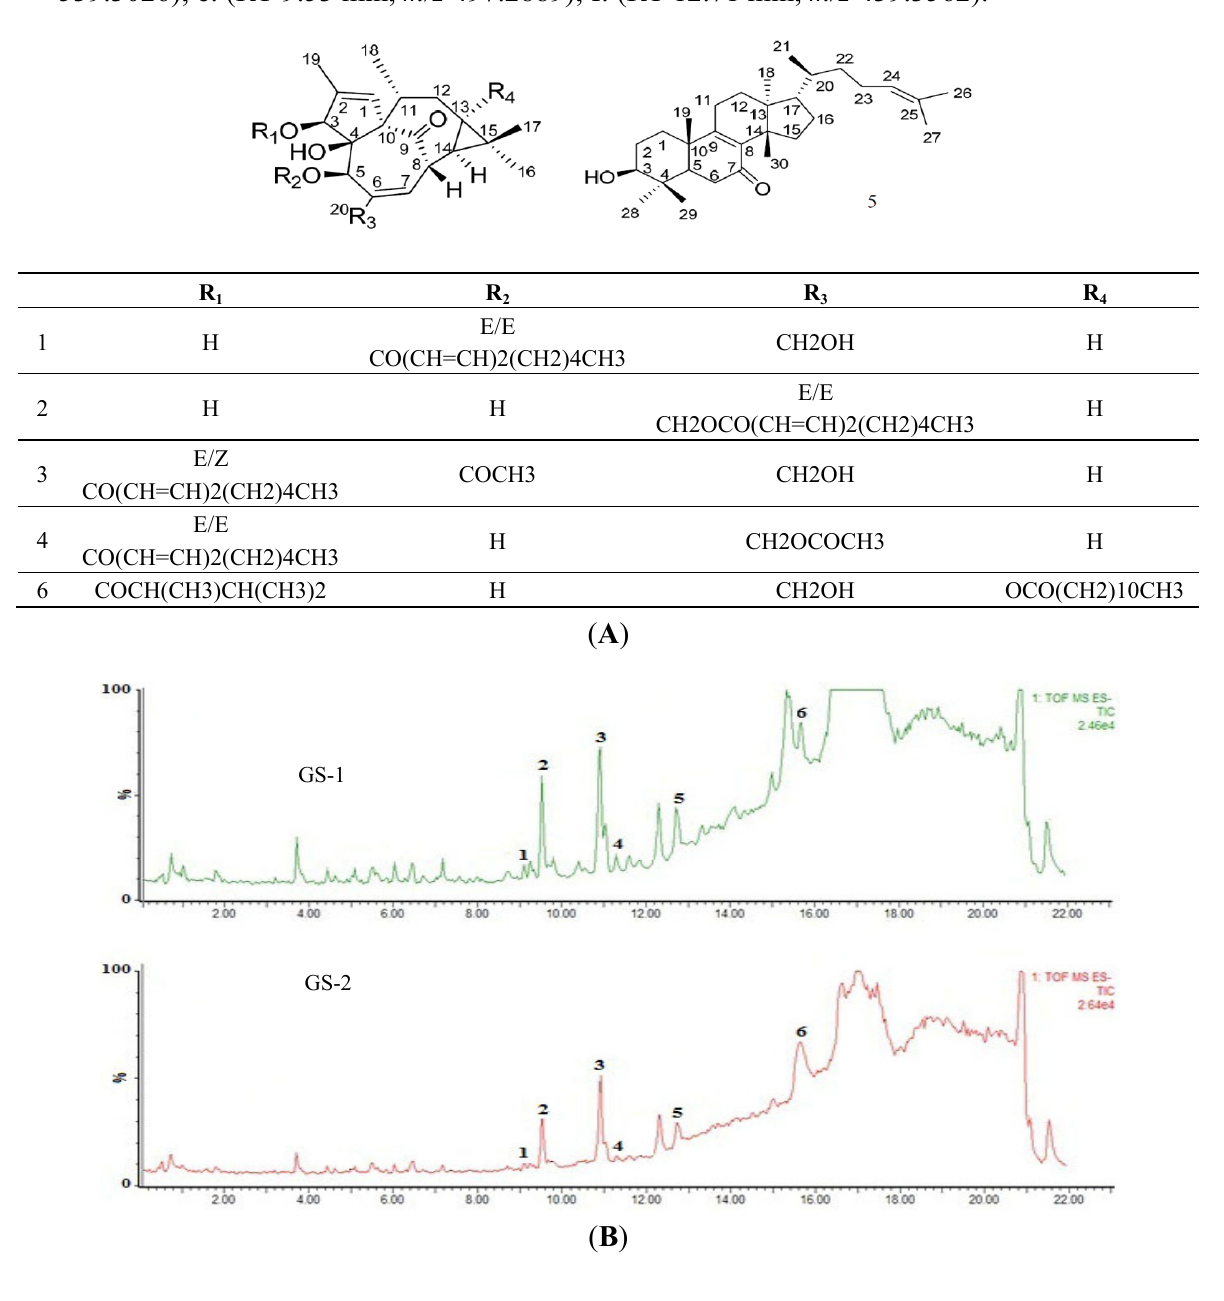
Figure 1. The five diterpene and one triterpene as the most differentiating components were analysized by UPLC-QTOF/MS. ( A ) The chemical structures of the six reference compounds. ( B ) UPLC-negative-ion ESI-MS total ion-current (TIC) profile of GS-1 and GS-2 (peaks 1 – 6 are the peaks of the six reference compounds). ( C ) OPLS-DA/S-plot of GS-1 and GS-2 using Pareto scaling with mean centering. a : (RT 15.69 min, m/z 643.4228); b : (RT 9.11 min, m/z 497.2883); c : (RT 11.29 min, m/z 539.3015); d : (RT 10.91 min,